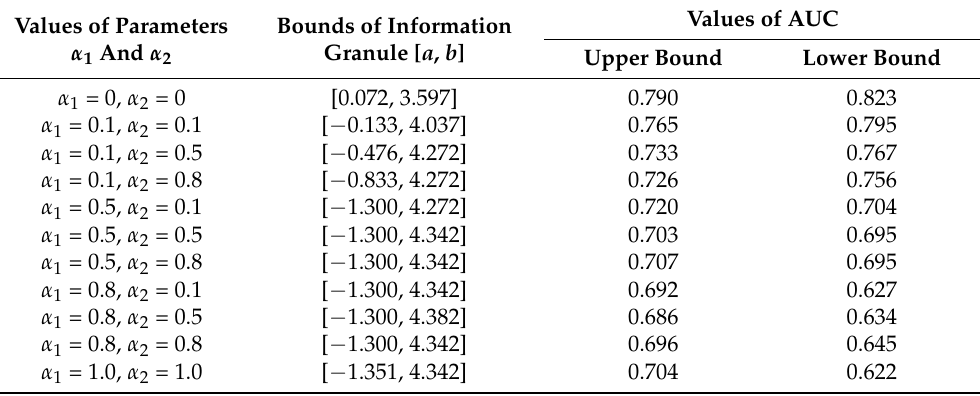
Table 2. Summary of the bounds of information granules and AUC values for different values of α 1 and α 2